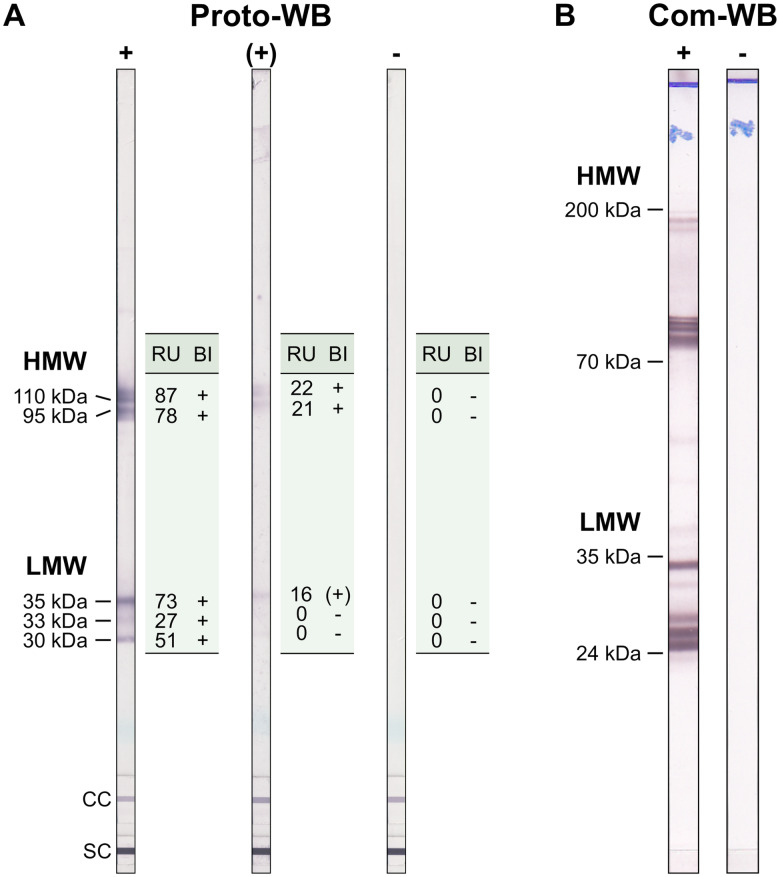
Example results of (A) the Toxocara Proto-WB and (B) the Com-WB. Bands of lower molecular weight are specific for anti-Toxocara antibodies. For Proto-WB, results of each of the bands were categorized (band interpretation, BI) based on RUs. +, positive; (+), borderline; −,negative; LMW, low-molecular weight; HMW, high-molecular weight; SC, serum control; CC, conjugate control.